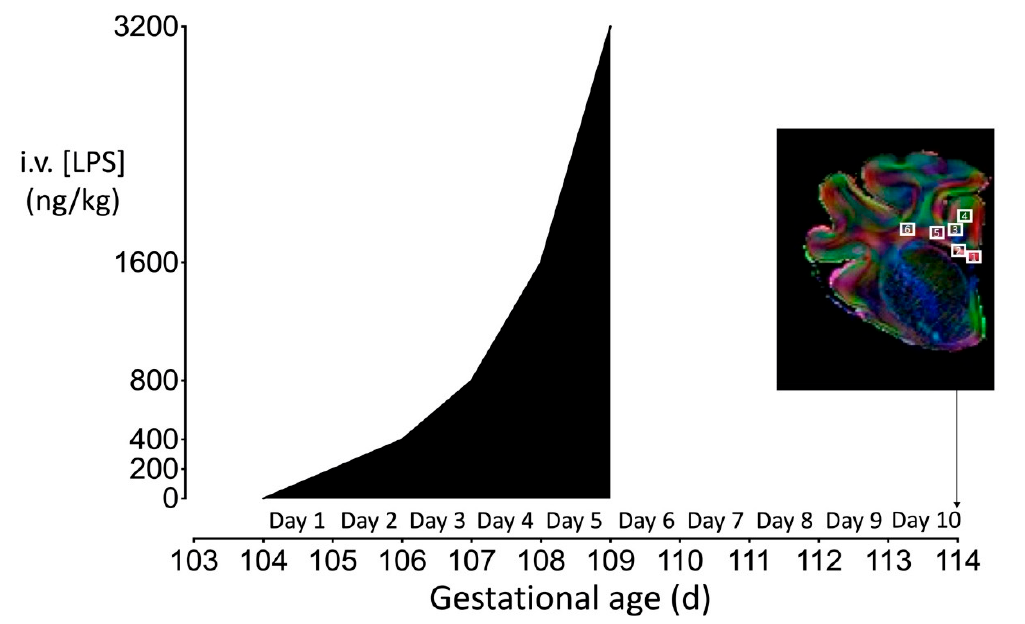
Figure 6. Schematic outlining the study design. The study consisted of two groups: control ( n = 6), LPS ( n = 7). The dark shaded area represents the period of progressive LPS infusion (200 ng LPS for the first 24 h, then doubled every 24 h for the next 96 h). Controls received an equivalent volume of vehicle (saline) during the infusion period. Continuous physiological recordings were performed throughout the experimental period. Fetal preductal arterial blood was collected every morning starting from 30 min before increasing the LPS or saline infusion and at 6 h after increasing the infusion for measurement of cytokine levels. Representative direction-encoded color map outlining the regions of interest sampled for MRI and histological analyses. Brain regions used for analysis were collected from the forebrain at the level of the mid-striatum from sections taken approximately 23 mm anterior to stereotaxic zero. White squares indicate regions of interest (ROIs) for assessment of the corpus callosum (1, 2), intragyral white matter within the first (3, 4) and the periventricular white matter (5, 6). The diffusion-weighted images and ROIs chosen for MRI analysis corresponded with the same regions used for histological assessment.